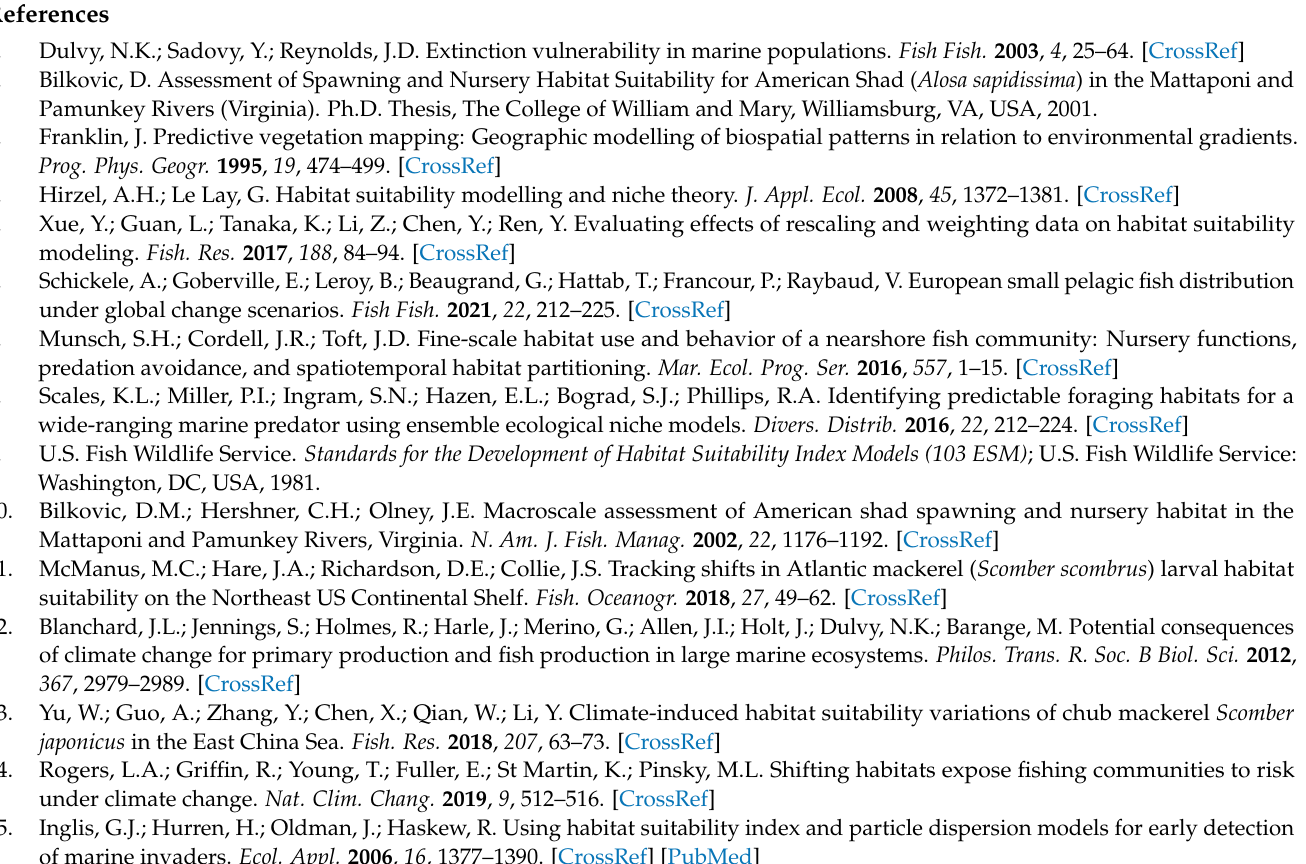
Figure S3: The spatial distribution of the sea temperature and salinity in the spring and summer in the Yangtze Estuary (2018–2020). Figure S4: The spatial distribution of SI of environmental factors for three larval gobies in the Yangtze Estuary. Figure S5: Results for R. giurinus derived by GAM (left two panels: spring; right two panels: summer). Figure S6: Results for A. pflaumii derived by GAM (left two panels: spring; right two panels: summer). Figure S7: Results for O. rubicundus derived by GAM (left two panels: spring; right two panels: summer). Table S1: Summary of environmental factors in the spring and summer in the Yangtze Estuary